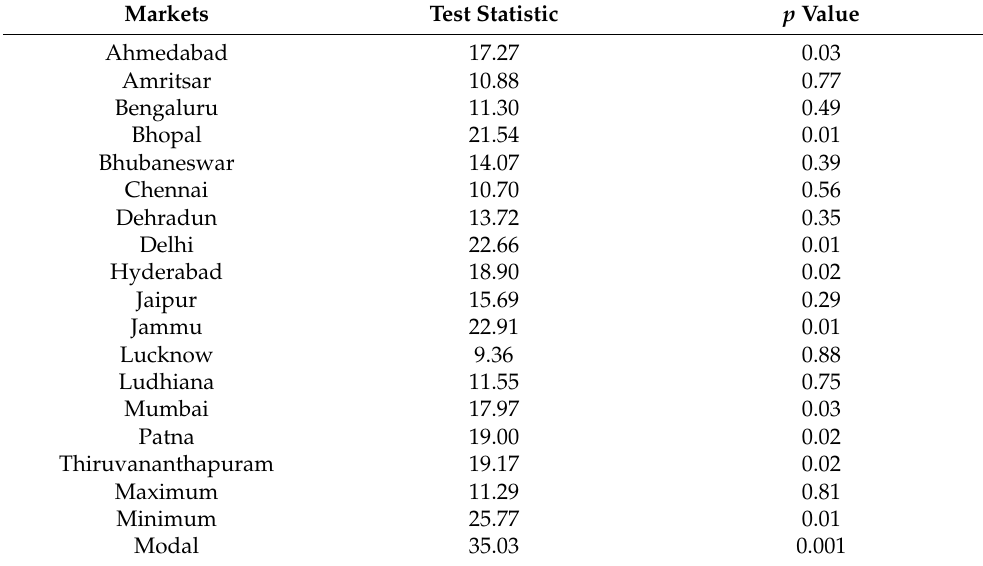
Table 7. Result of the Sup-LM